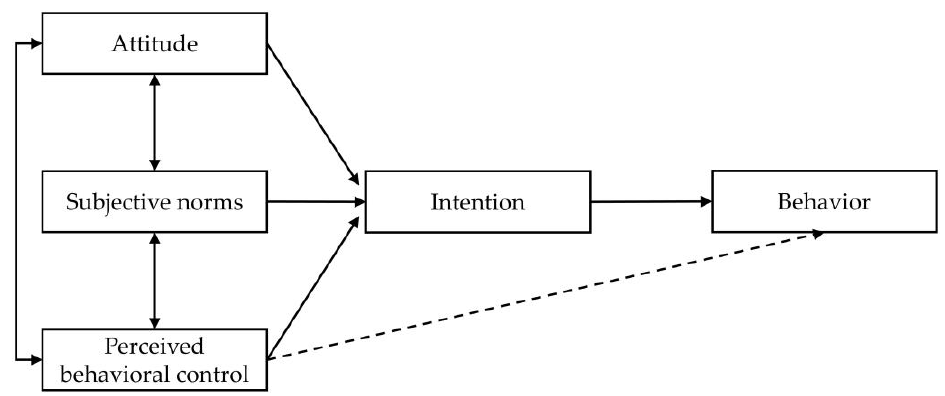
Figure 1. The theory of planned behavior.